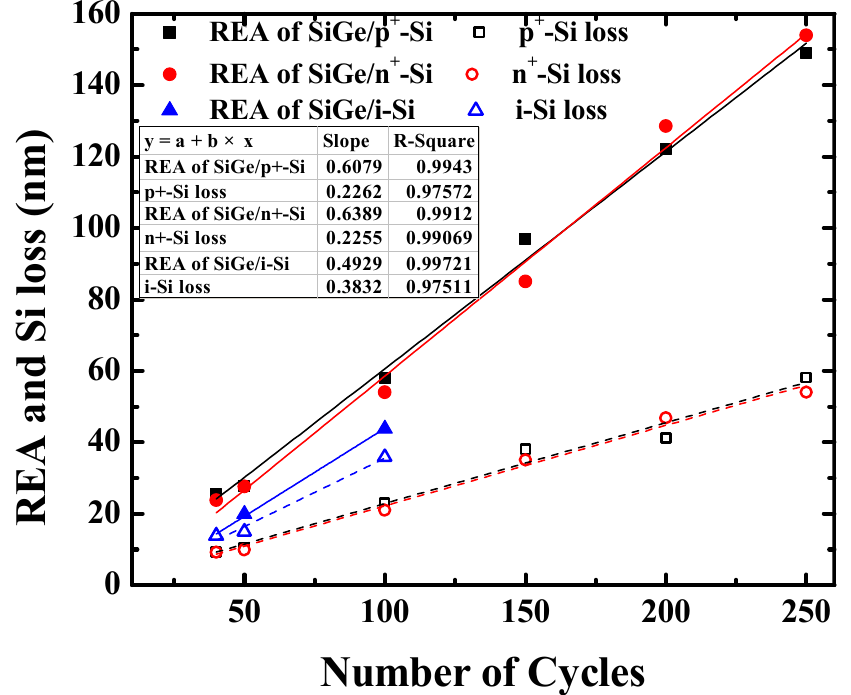
Figure 6. Dependence of the REA and Si loss on the number of etching cycles for SiGe/n + -Si, SiGe/p + -Si, and SiGe/i-Si. The scatters are the experimental data, and the lines are the linear fitting curves of the experimental data. The slopes represent the REPC and silicon etching amounts for each cycle (EPC).